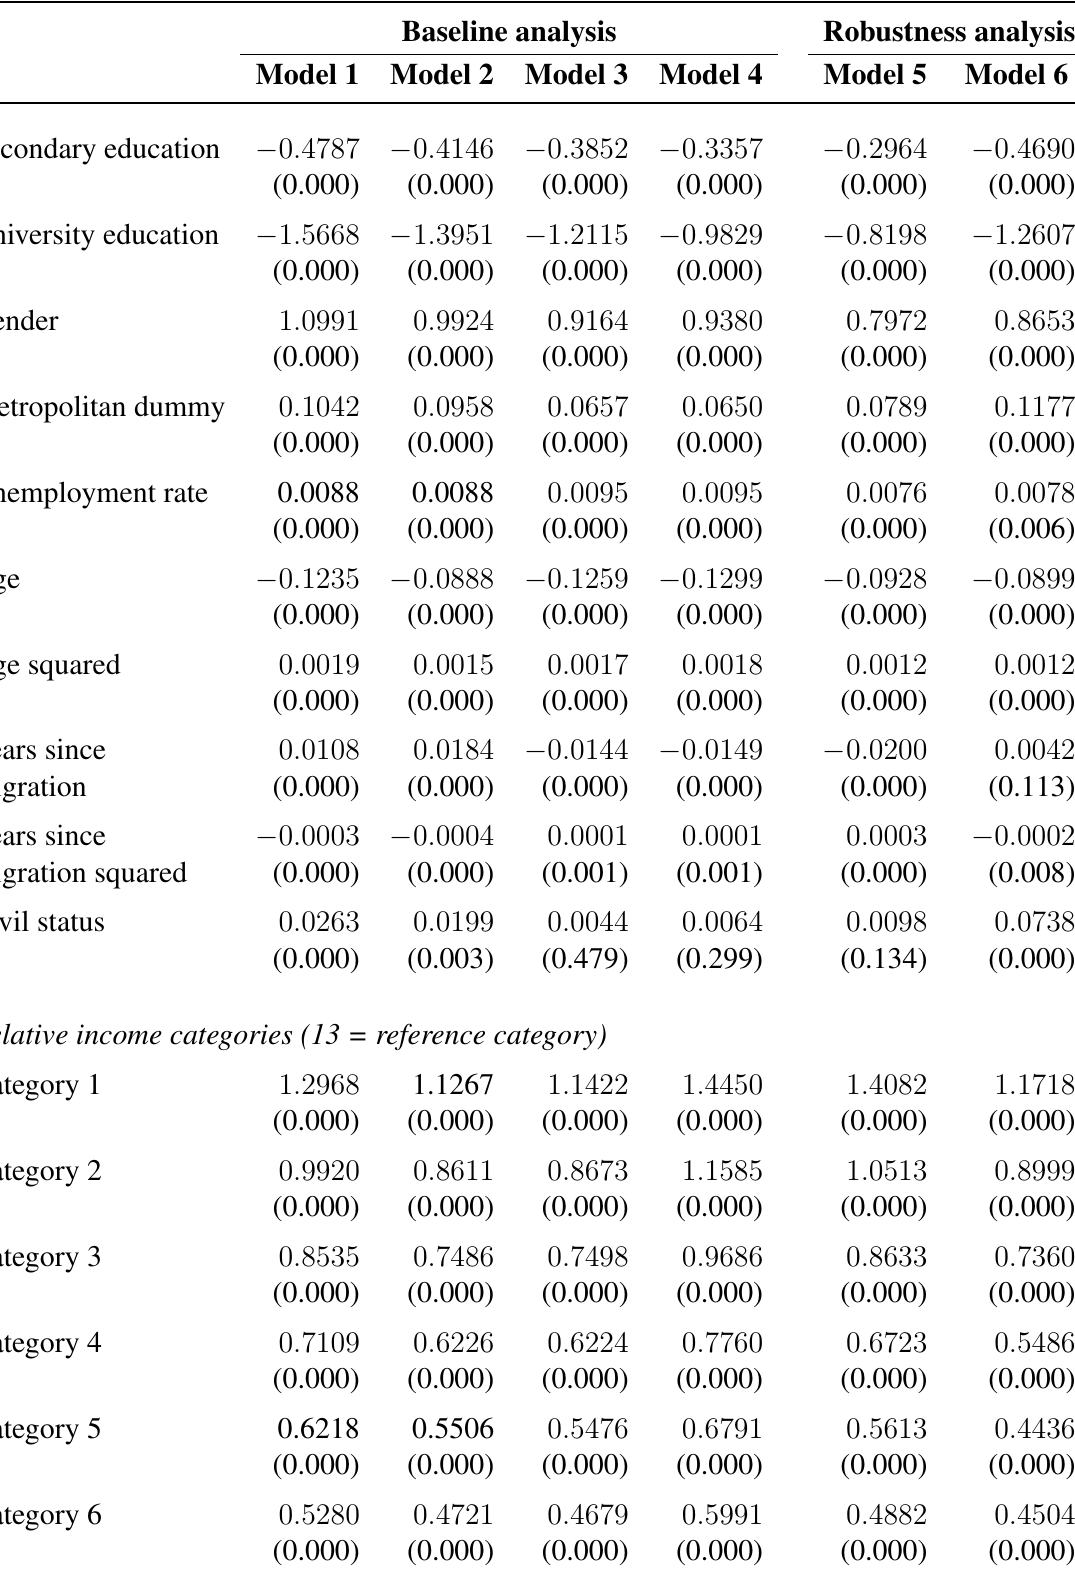
Table 2. Estimations of the discrete-time hazard of being absent due to sickness in a given year: logit models with Gaussian random